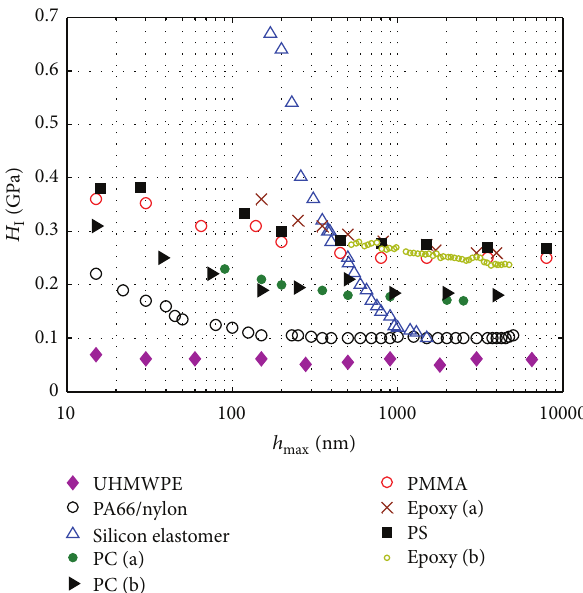
Figure 2: Indentation hardness 𝐻 I versus ℎ max for various polymers redrawn from [15] (UHMWPE, PC (b), PMMA, PS), [16] (PC (a), epoxy (a)), [26] (epoxy (b)), [36] (silicon elastomer), and [39]